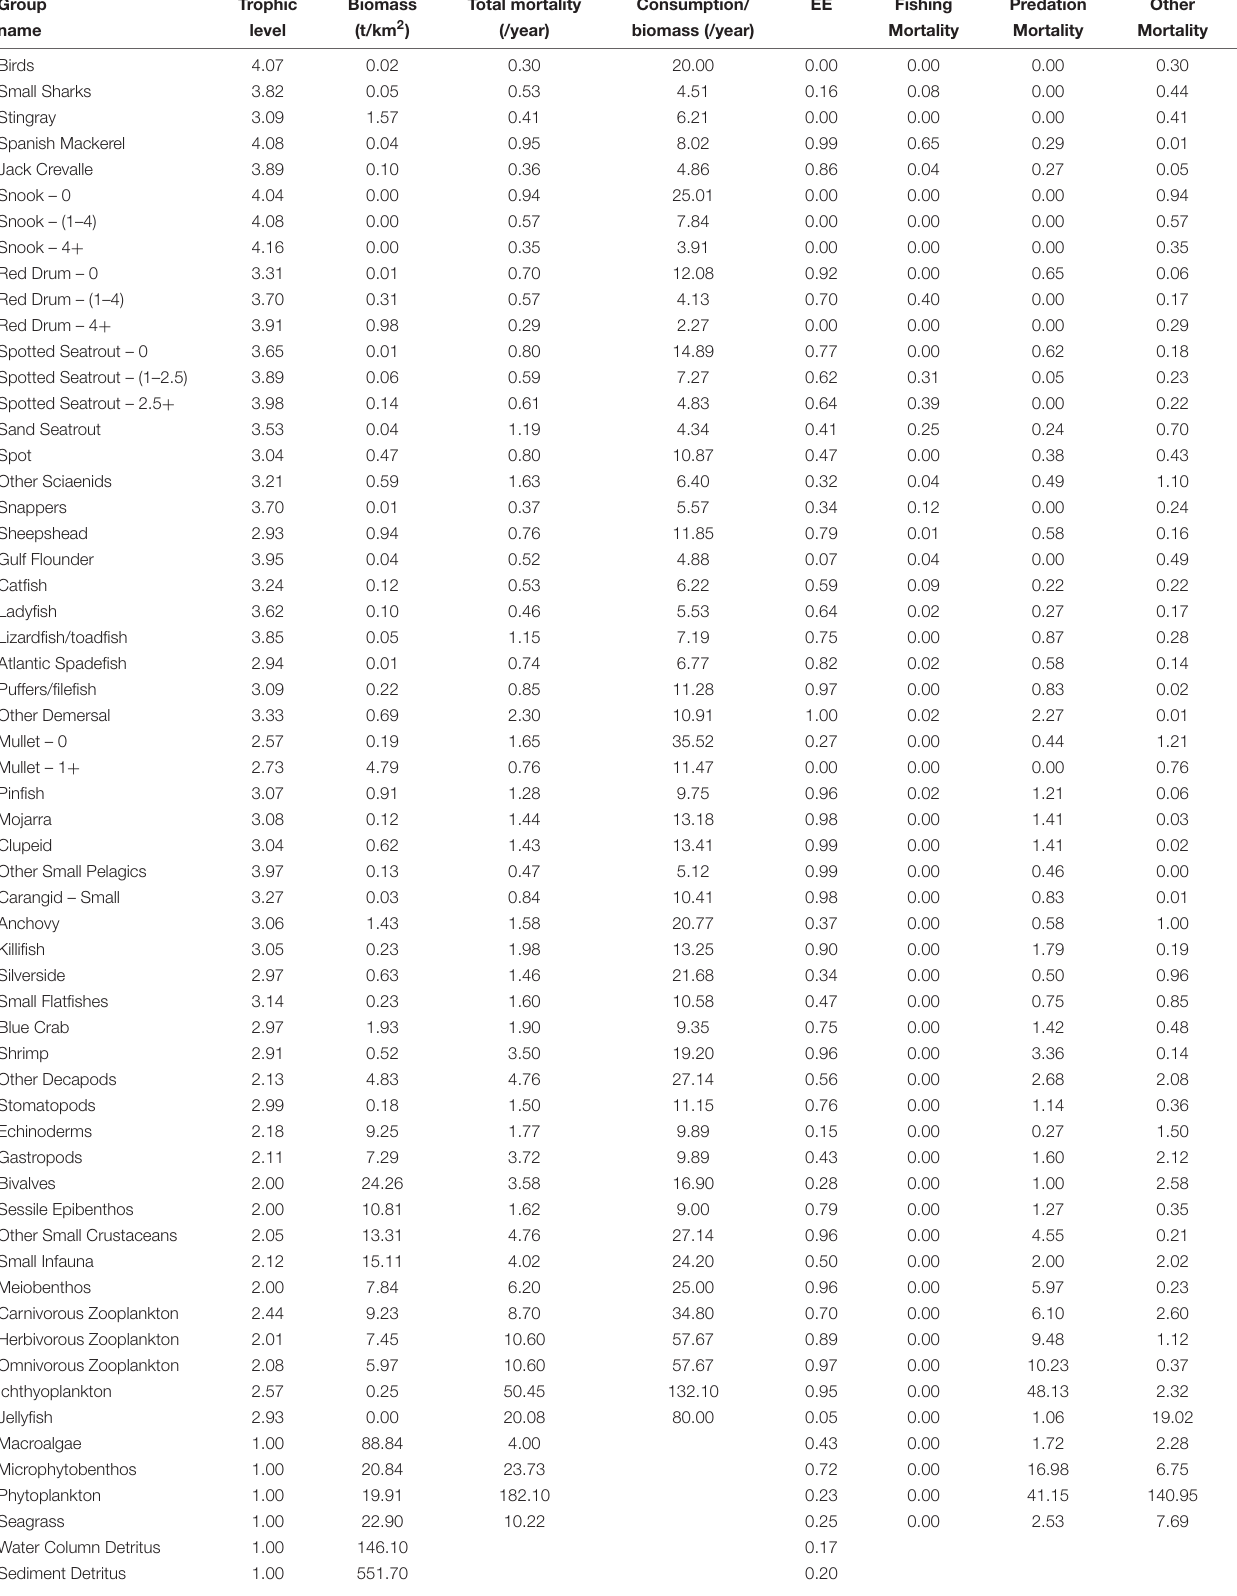
TABLE 1 | Basic estimates of model variables for all functional groups.